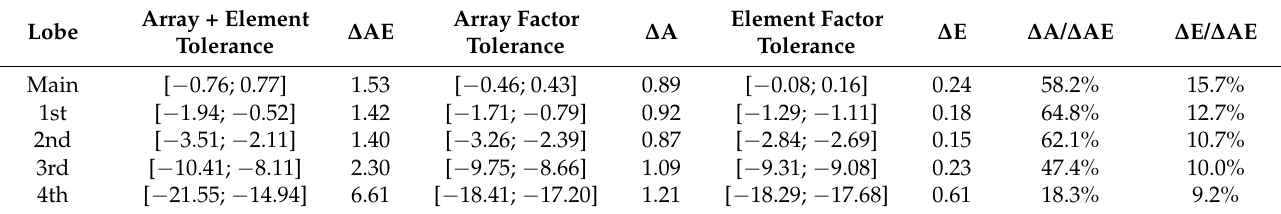
Table 8. SLL interval value in Figure 26 (10 × 10 array).